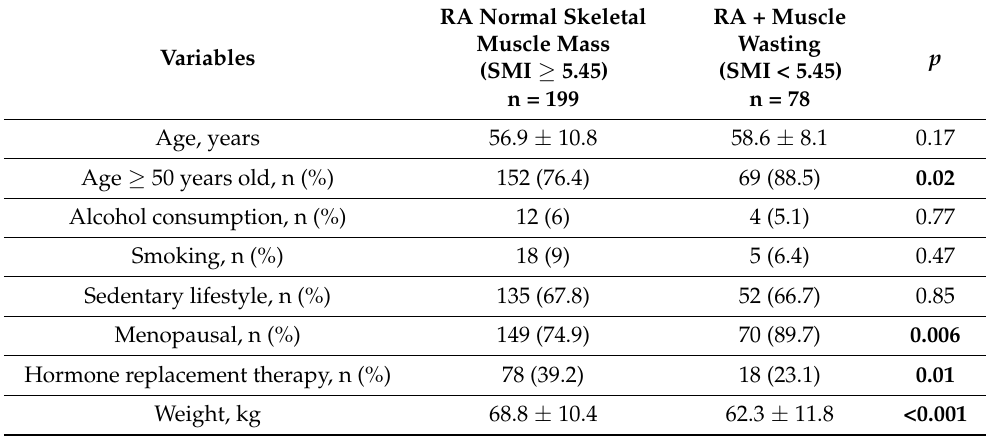
Table 2. Comparison of clinical characteristics in women with Rheumatoid Arthritis with normal vs. low-skeletal muscle